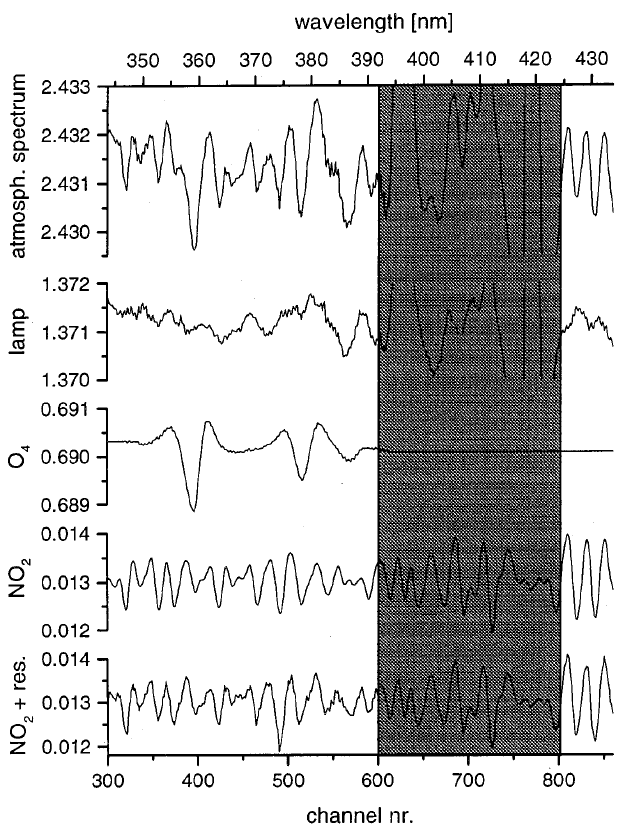
Table 1. Wavelengths and detection limits for DOAS Species Wavelength of prominent band, nm